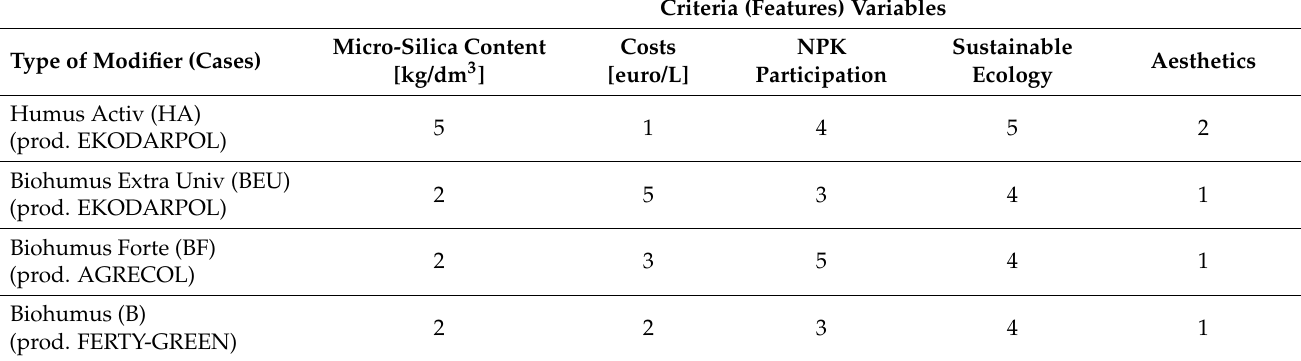
Table 2. Characteristics of organic silicate mass fillers for technical and economic analysis in median values.